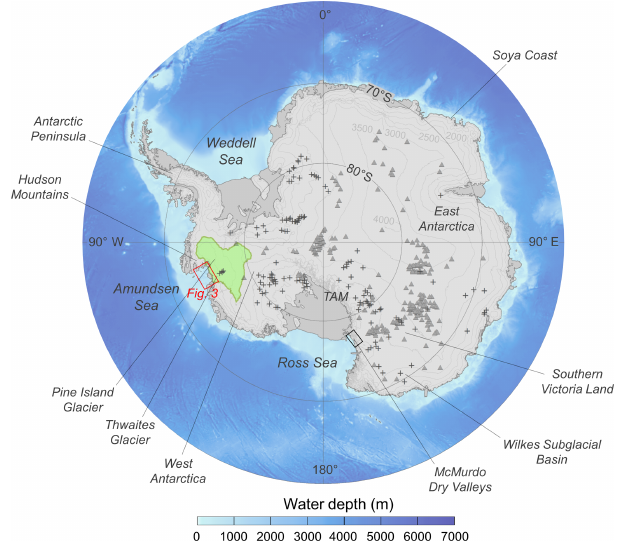
Figure 1. Overview map displaying the location of features and regions referred to in the text. The catchment drained by contem- porary Pine Island and Thwaites glaciers is highlighted in green. The black box shows the portion of the Transantarctic Mountains (TAM) containing Wright Valley, the Royal Society Range, the Convoy Range, and the Asgard Range, in which channel features have been observed. The area shown in Fig. 3 is displayed as a red box. The locations of subglacial lakes observed from radio–echo sounding (grey triangles) and actively draining subglacial lakes ob- served from satellite altimetry ( + ) are shown from Wright and Siegert (2012) and Smith et al. (2017). Regional bathymetry and ice surface elevation is from Bedmap2 (Fretwell et al.,